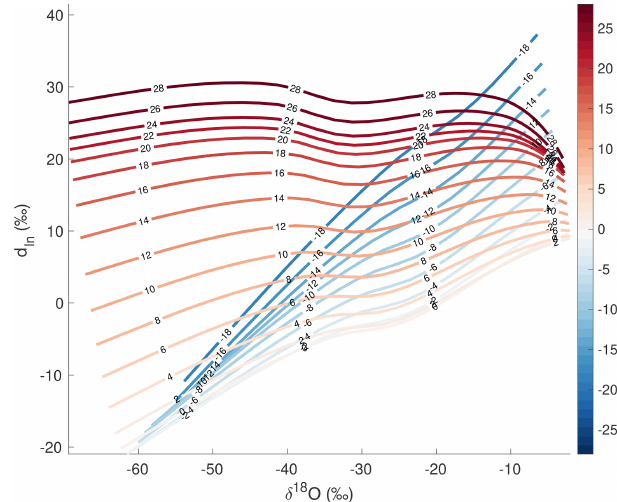
Figure A29. Isotope model results colored by initial evaporation air temperature T 0 ( ◦ C) using base model assumptions. For initial evaporation air temperatures below 0 ◦ C there are non-unique re- sults in the δ 18 O and d ln